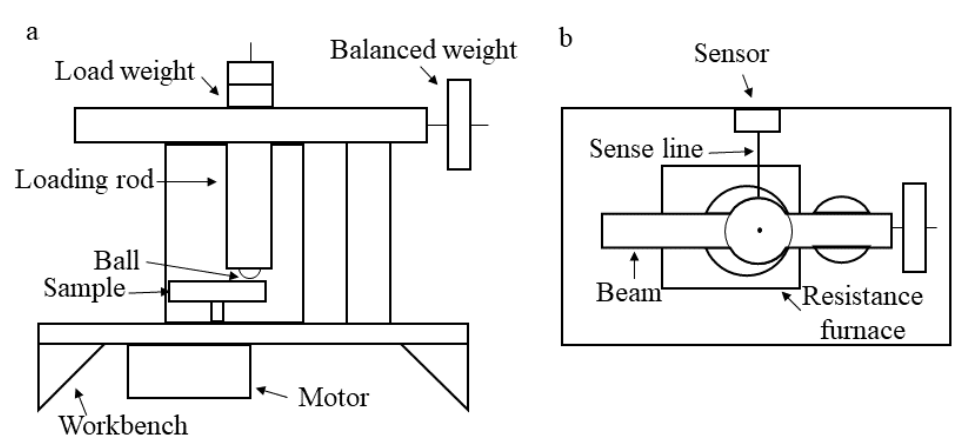
Figure 1. Microstructure of sample 4#.